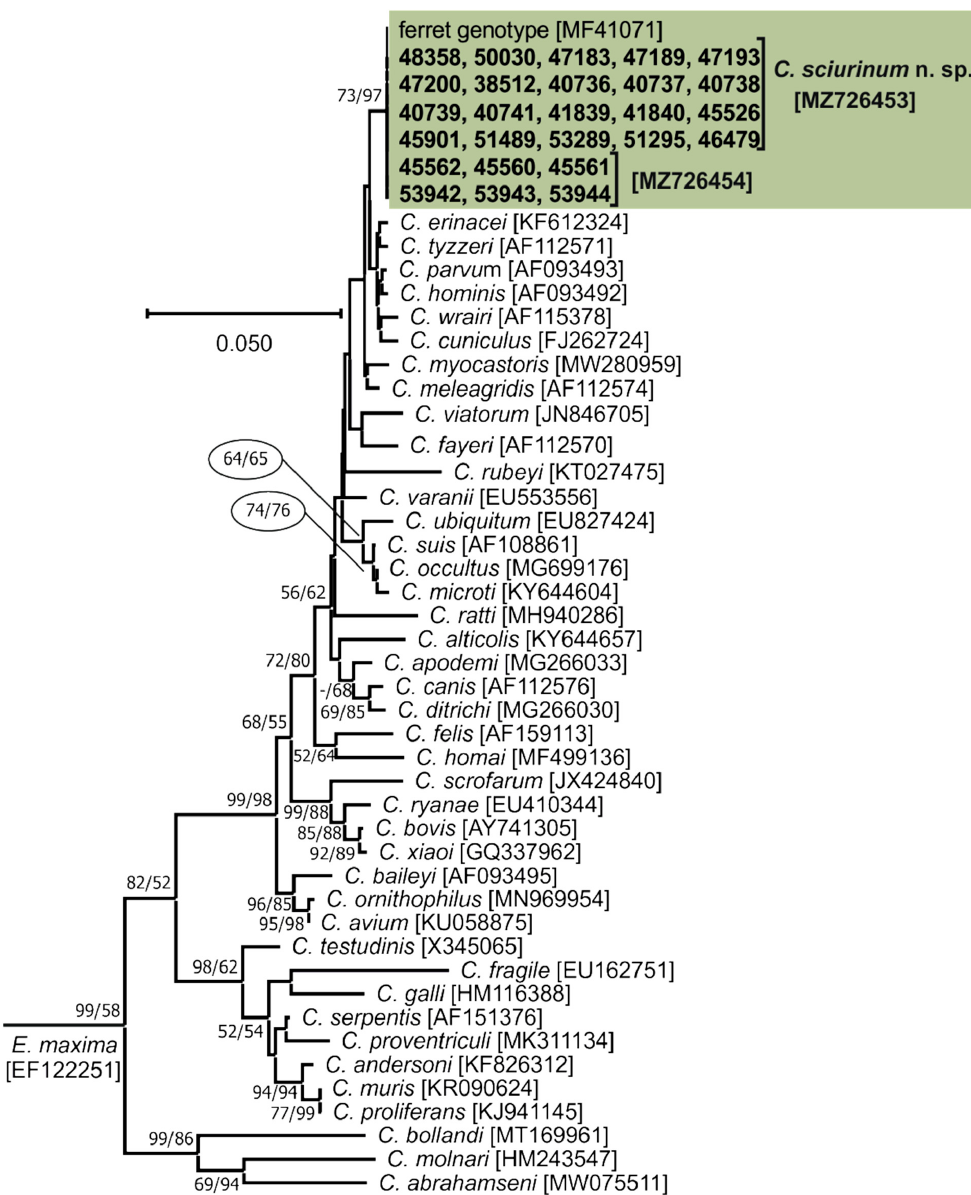
Figure 2. Evolutionary relationships of Cryptosporidium spp. at the small subunit rRNA ( SSU ) locus inferred by Maximum Likelihood (ML) and Neighbor-Joining (NJ) analyses using a General Time Reversible model with a gamma distribution: Percentage support (>50%) from 1000 pseudoreplicates from ML and NJ analysis, respectively, are indicated next to supported node. The ‘-’ indicates support value <50%. The tree is drawn to scale, with branch lengths in the same units as those of the evolutionary distances used to infer the phylogenetic tree. The analysis involved 70 nucleotide sequences and there were a total of 771 positions in the final dataset. The tree was rooted with the SSU sequence of Eimeria maxima [EF122251]. Sequences obtained in this study are identified by isolate number (e.g., 45901). The GenBank Accession number is in parenthesis. Isolates detected in this study are colour-coded.